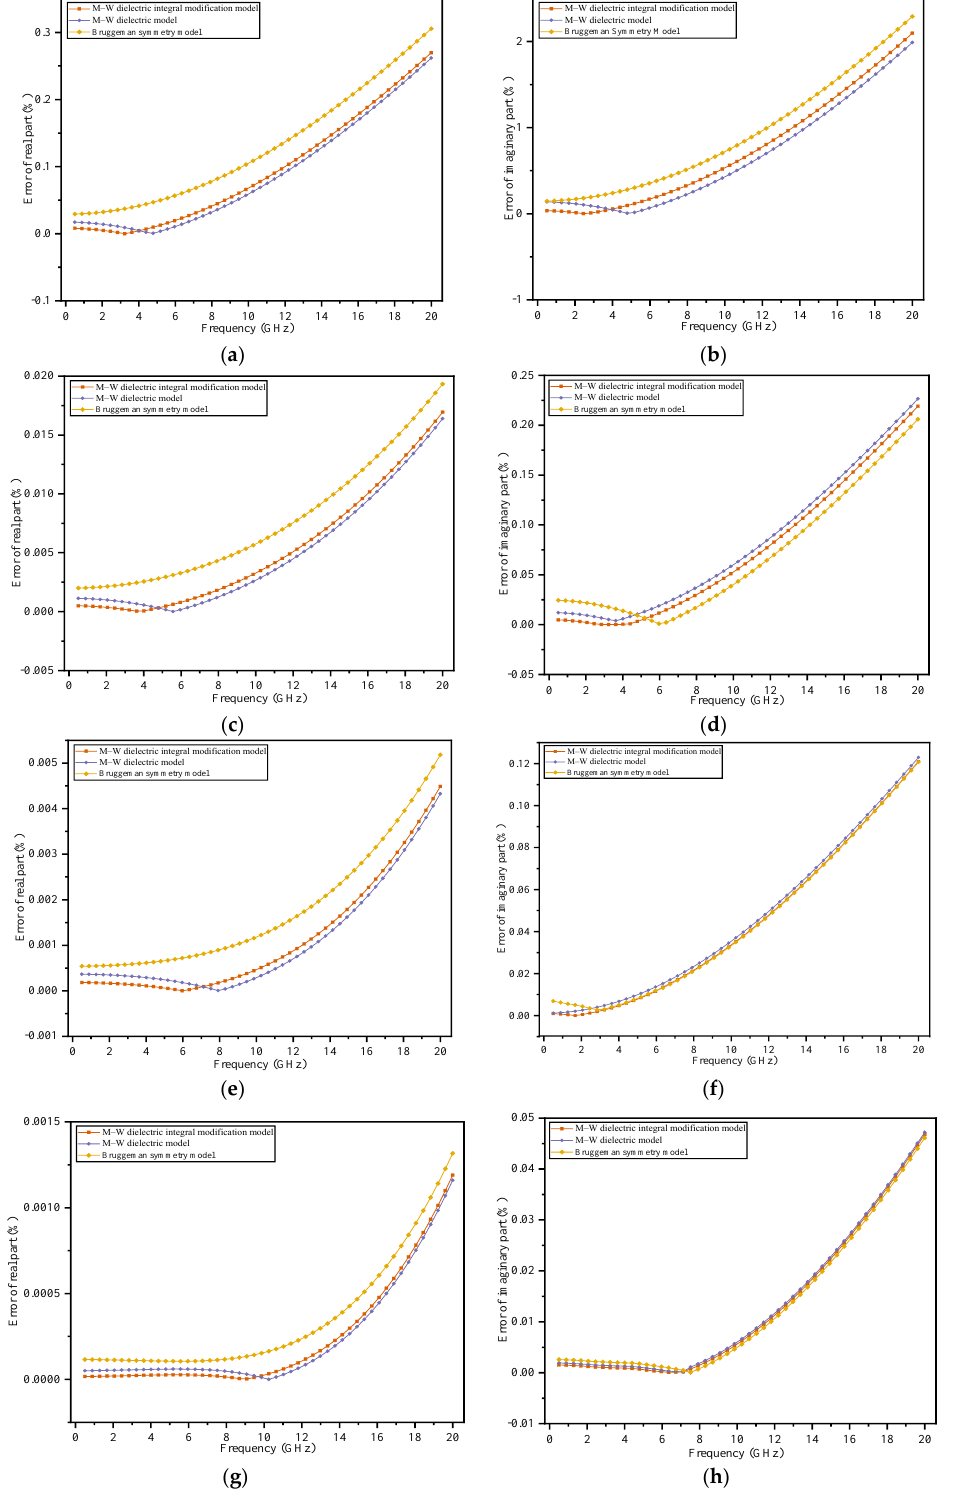
Figure 6. Error comparison of different models under multiple moisture contents. When the moisture content is 1% or less, the Lichtenecker logarithmic model, Rayleigh model, and series-parallel calculation formula have significantly higher errors than the Bruggeman symmetric model, so the error is omitted: ( a , b ) φ = 1%; ( c , d ) φ = 0.26%; ( e , f ) φ = 0.14%; ( g , h ) φ = 0.06%. Figure 6g,h shows that when the moisture content is 0.06%, the dominant frequency range of the real part extends to 9.6 GHz, and the dominant frequency range of the imag- inary part extends to 7.2 GHz; that is, the modification model performance improves com- pared with that at a higher moisture content.